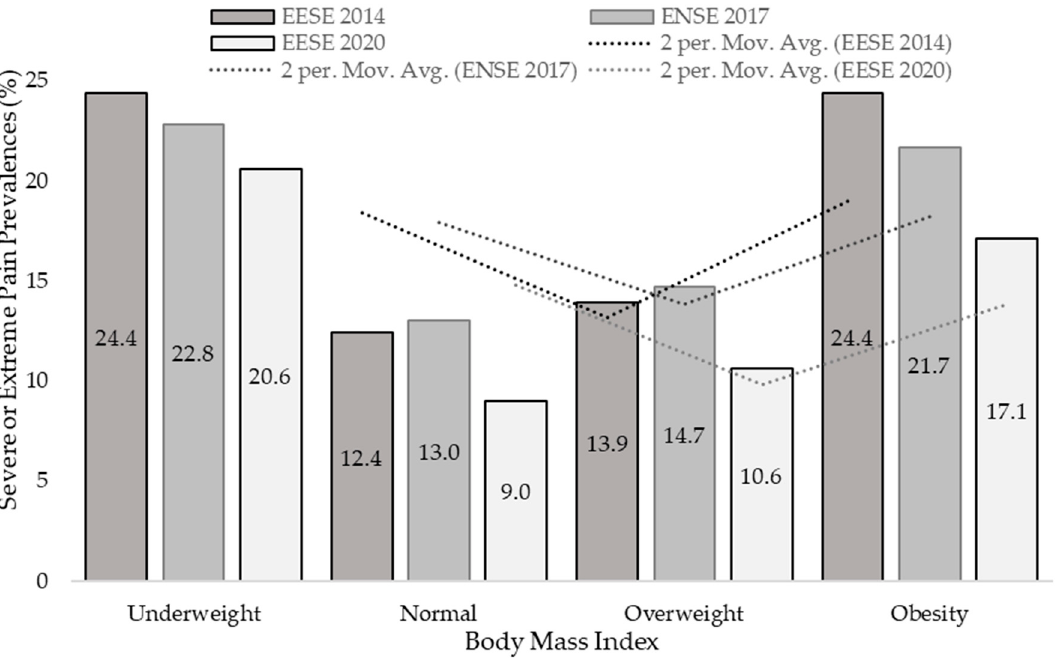
Figure 5. Severe/Extreme Pain Degree according to the Body Mass Index in the Spanish population in the three surveys EESE2014, ENSE2017, and EESE2020.